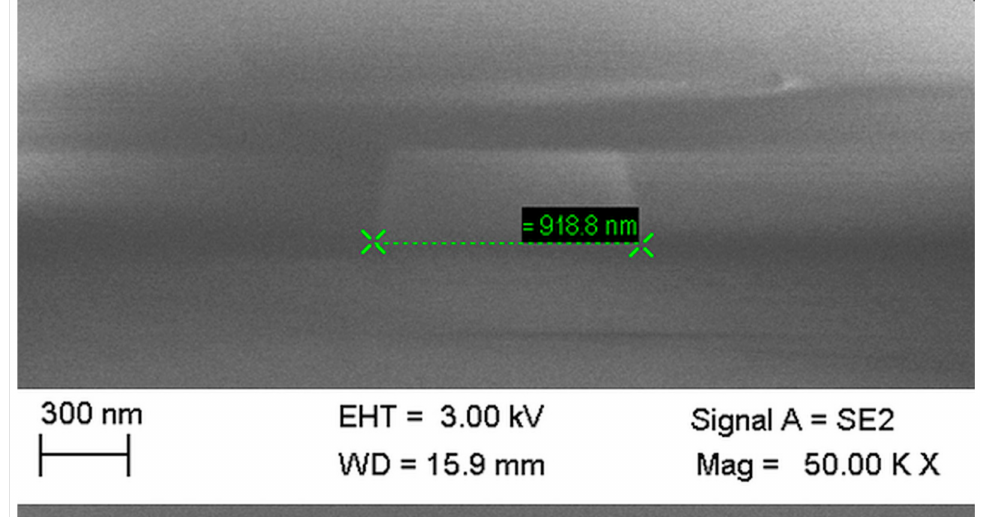
Figure 22. SEM image of cross-section of WG with 1 µ m designed